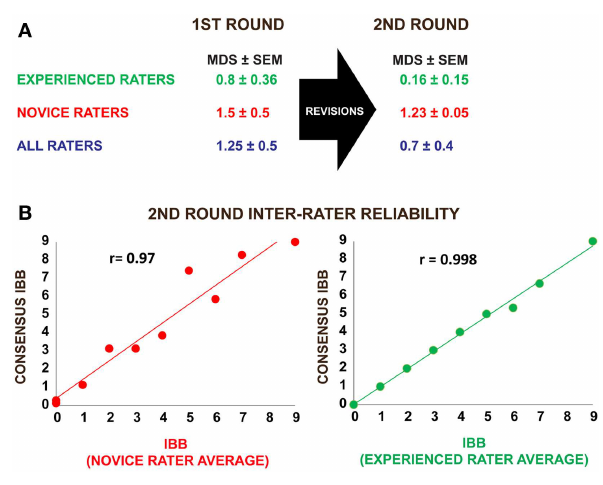
FIGURE 3 | Results of inter-rater reliability testing using a standardized set of rat behavioral videos before and after revision of the